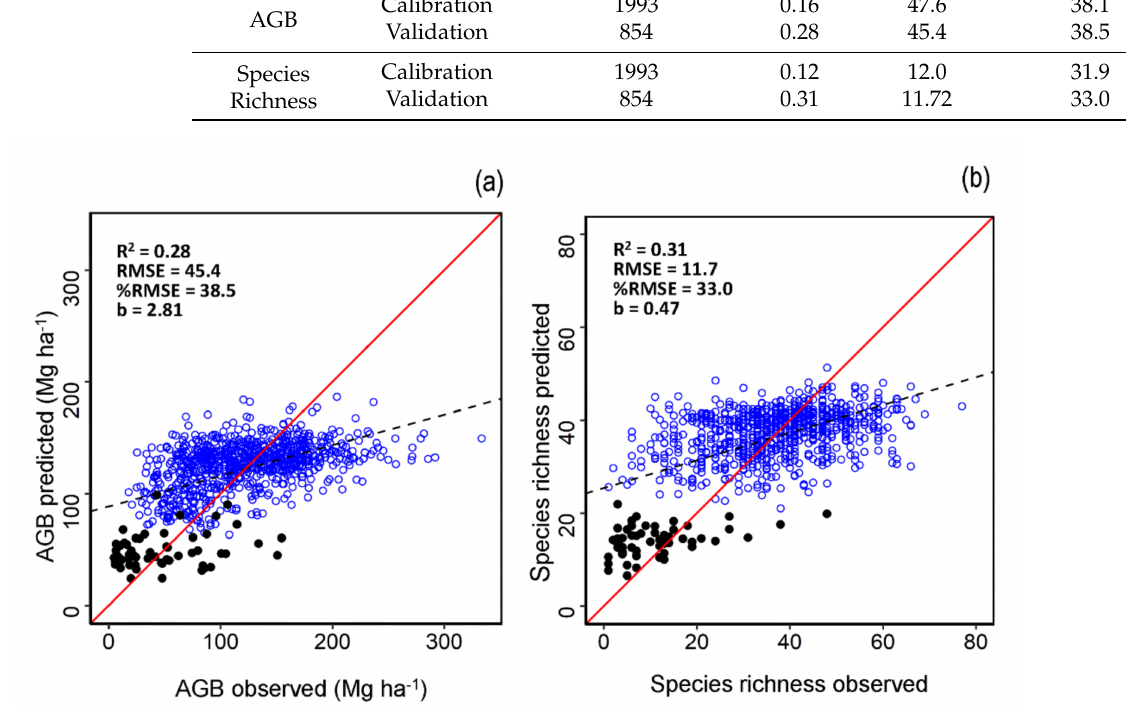
Figure 2. Comparison of observed versus predicted values for aboveground biomass (AGB) ( a ) and species richness of trees ( b ). Red lines are reference lines 1:1, while dashed lines are regression lines. The coefficient of determination (R 2 ), the Root-Mean-Square Error (RMSE), the Percentage of Root-Mean-Square Error (%RMSE) and the bias were calculated using both vegetation classes (tropical dry forests and other vegetation types). Open blue circles represent forest plots, while filled black circles correspond to other vegetation-type